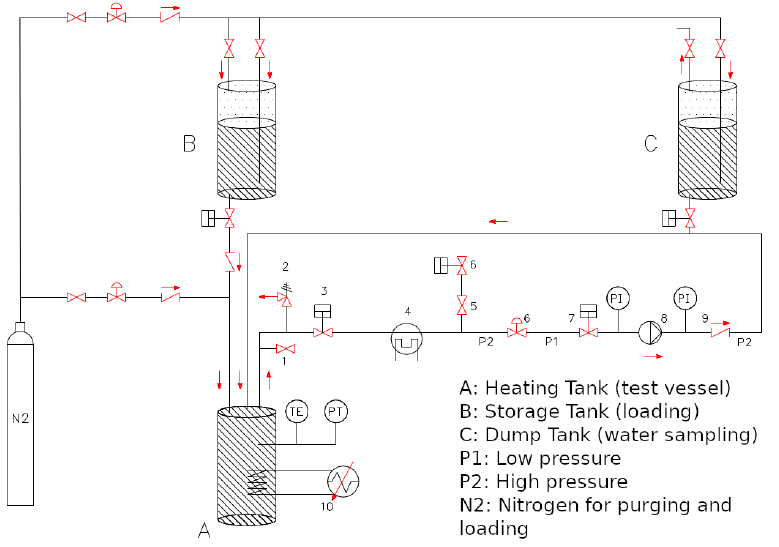
Figure 2. Layout of the HTHP corrosion testing loop. The test vessel (A) capacity was 2